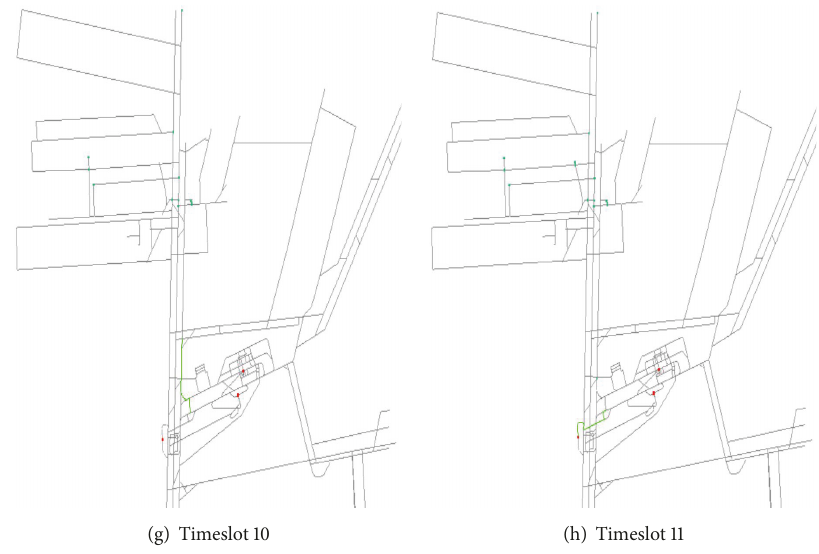
Figure 6: The visualization results of dynamic